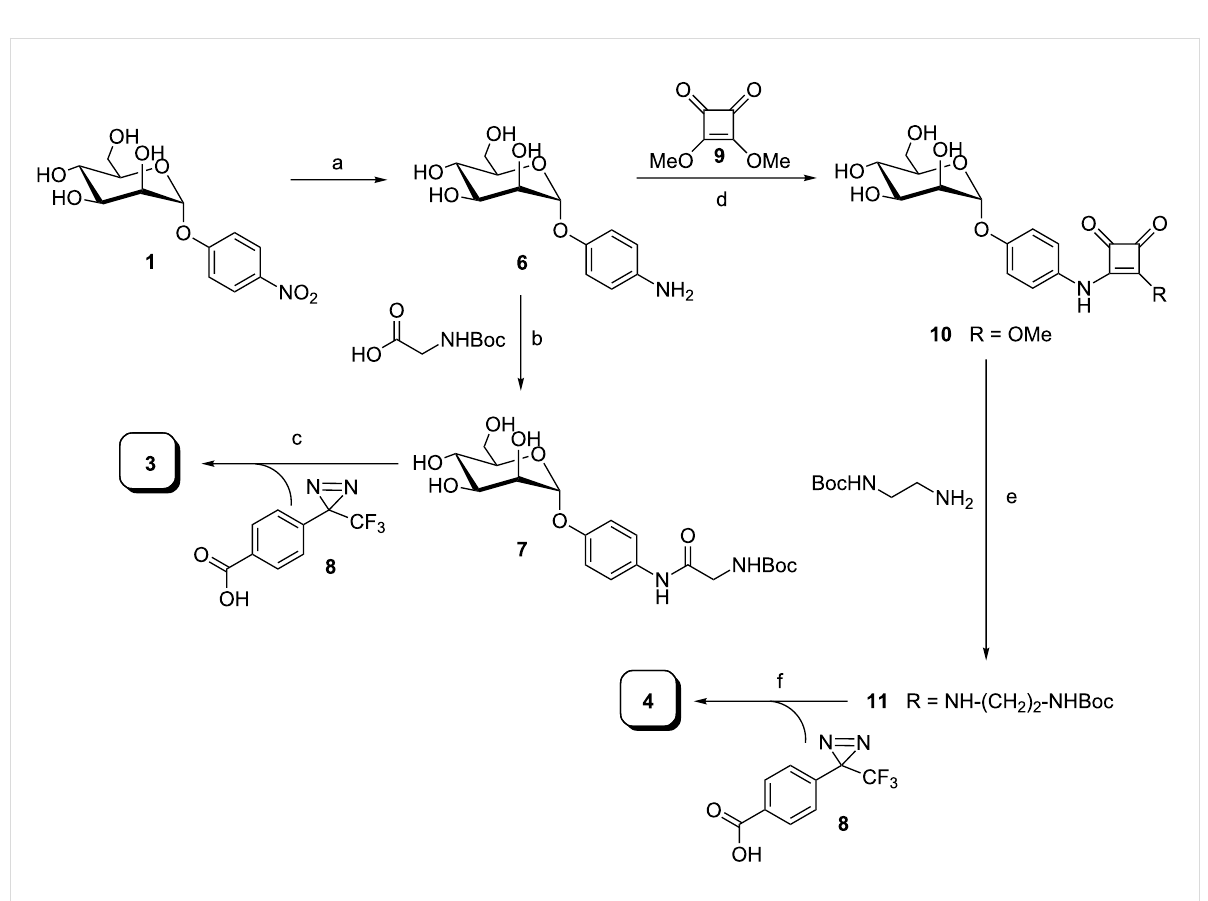
Scheme 1: Synthesis of photolabile α -D-mannosides 3 and 4 . a) H 2 , Pd-C, methanol, rt, 6 h, 94%; b) HATU, DIPEA, dry DMF, N 2 , rt, overnight, quant.; c) 1. 50% TFA in water, rt, 3 h; 2. HATU, 8 , DIPEA, dry DMF, N 2 , rt, 14 h, 19% (over 2 steps); d) dry methanol, rt, 16 h, 59%; e) Et 3 N, dry methanol, rt, 15 h, 92%; f) 1. 50% TFA in water, rt, 3 h; 2. HATU, 8 , DIPEA, dry DMF, N 2 , rt, overnight, crude product (68% over 2